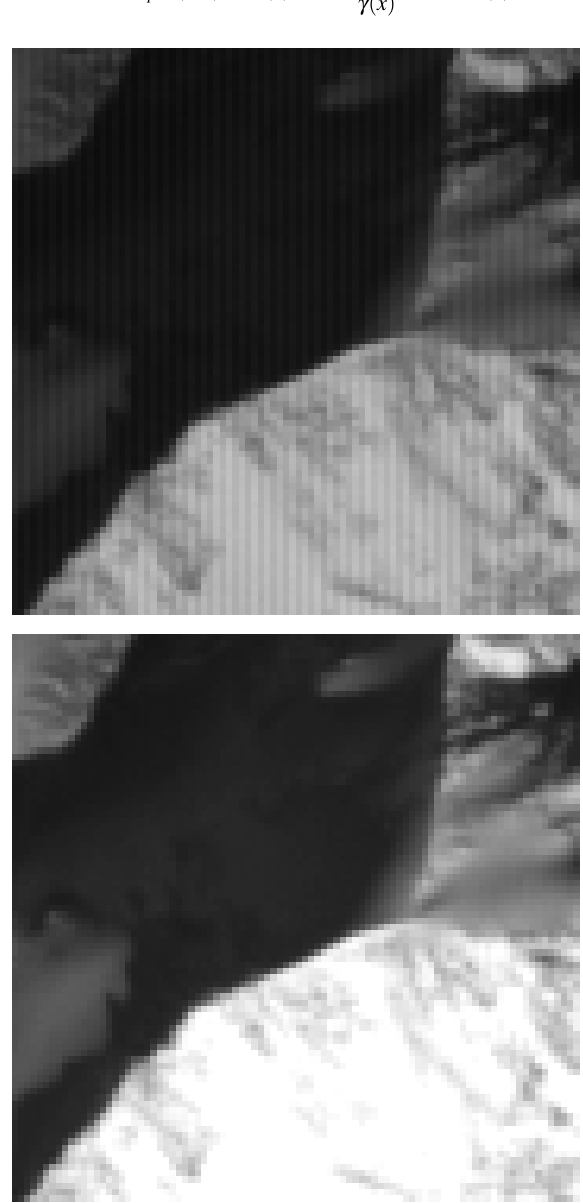
Figure 3: Extract of the VNIR band 3N of an ASTER scene. Top : Original image. Bottom : After